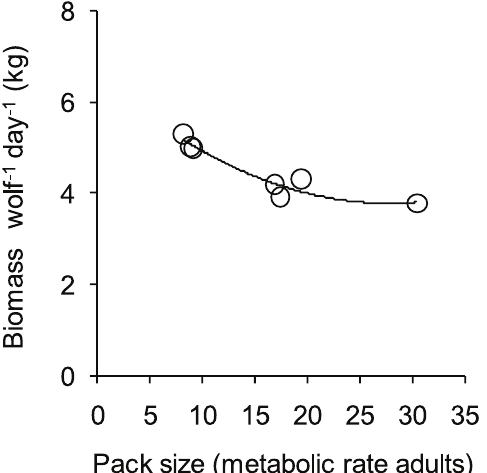
Figure 5. Rates of prey acquisition (kg wolf 2 1 day 2 1 ) during June and July in relation to pack size. Pack size is determined as the number of metabolic-rate-adult-equivalent wolves (see Pups and prey acquisition rates ). The line represents the best fitting polynomial regression: y =6.58 – 0.20 x + 0.004 x 2 ( R 2 =0.92, P , 0.01).